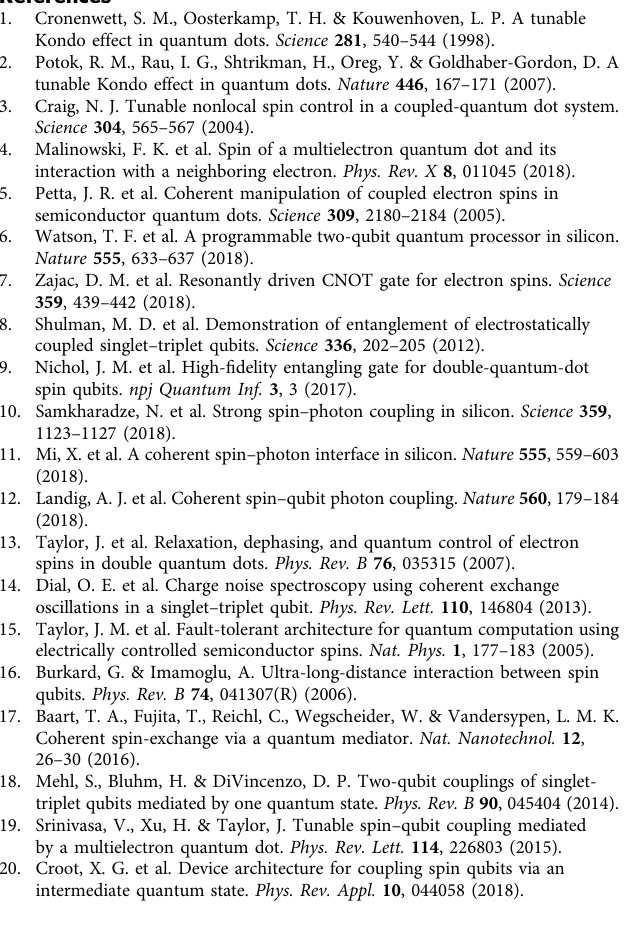
tary Figure 1. By de fi ning the measurement outcomes relative to the reference outcomes, the adverse effects of slowly drifting sensor signals are effectively removed: V rf ; L (cid:4) V f rf ; L (cid:2) V i rf ; L and V rf ; R (cid:4) V f rf ; R (cid:2) V i rf ; R . Implementation of exchange pulses with subnanosecond resolution . To achieve subnanosecond resolution of the exchange pulse, we interfered two nom- inally canceling signals generated by two arbitrary waveform generator channels, and applied the combined signal to the multielectron-dot plunger gate V M . Spe- ci fi cally, we set the two channels to output a square waveform of identical duration and amplitude, but with opposite polarity, and combine them using an inverted power splitter. The pulse period is set to the repetition time of the intended pulse sequence, the rising edge of the pulse is set to the beginning of the intended exchange pulse, while the falling edge happens at the beginning of the double-dot initialization step. By fi nely adjusting the channel skew of the arbitrary waveform generator, positive or negative V M pulses can be generated with subnanosecond control. While this method allows to overcome the limitations of the